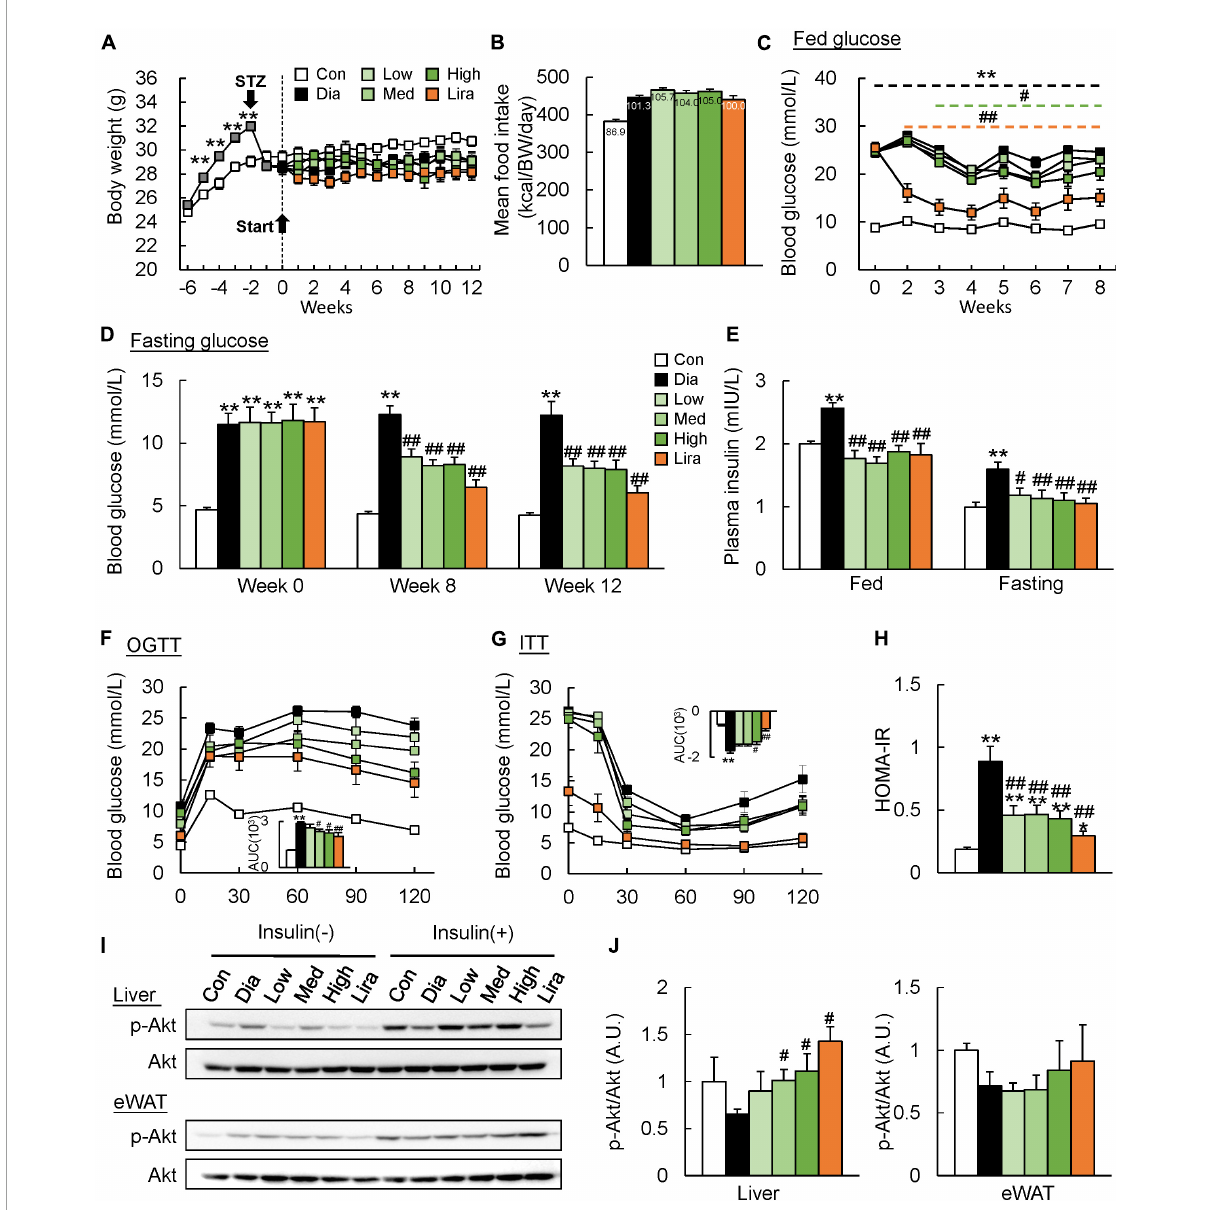
FIGURE1 CFP administration improves glucose tolerance and insulin sensitivity. (A) Body weight. (B) Daily food intake. (C) Blood glucose levels at fed state. (D) Fasting blood glucose levels at the baseline and after 8 and 12 weeks of treatment. (E) Fed and fasting plasma insulin levels. (F) Oral glucose tolerance test (OGTT). AUC, area under the curve. (G) Insulin tolerance test (ITT). (H) HOMA-IR index. (I,J) Immunoblots and quantification data of p-Akt levels in the liver and eWAT. Data are presented as the means ± SEM, * P < 0.05, ** P < 0.01 vs. control; # P < 0.05, ## P < 0.01 vs.